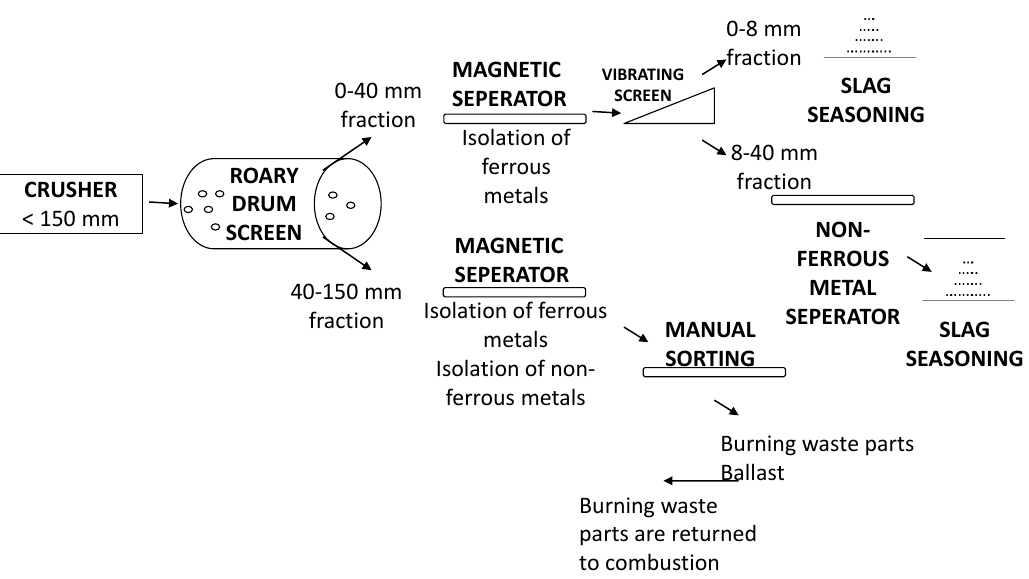
Figure 4. Installation responsible for sorting and mechanical treatment of MSWIBA [13].